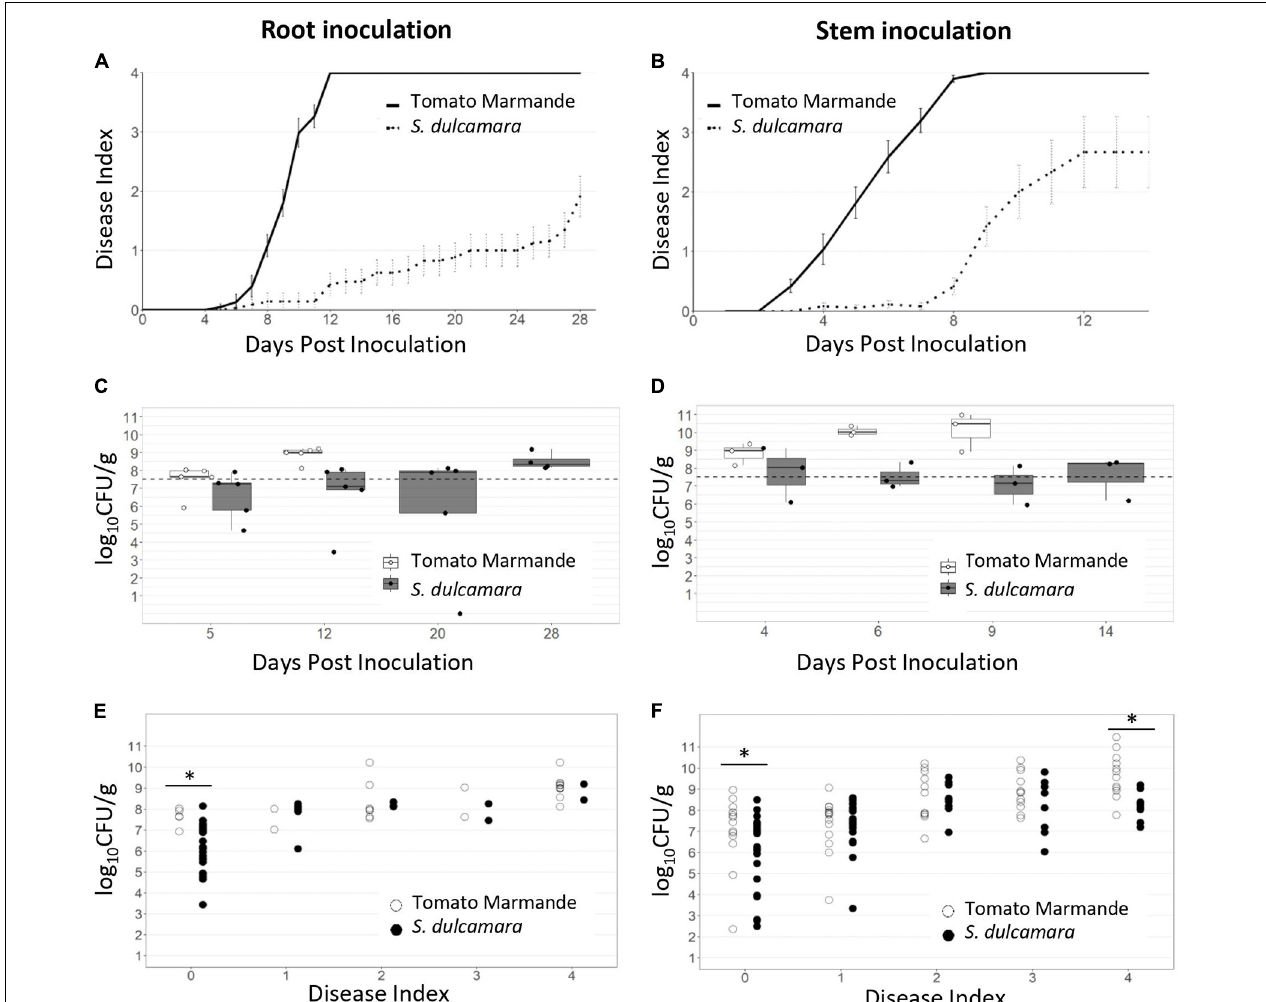
FIGURE 1 | Bacterial wilt evaluation in S. dulcamara and tomato cv. Marmande plants. Plants of the wild reservoir host S. dulcamara and tomato susceptible to bacterial wilt were root inoculated by soil soaking (A,C,E) or stem inoculated (B,D,F) with R. solanacearum UY031 carrying a luminescent reporter. (A,B) Wilting symptoms were recorded over time using a scale from 0 (no wilting) to 4 (completely wilted). n = 30–35 plants per plant species. (C,D) Bacterial concentrations in the stem at different time points from plants in panels (A,B) , respectively. n = 4–8 plants per sampling day. (E,F) Bacterial content in relation to wilting symptoms for each plant individual analysed of the two species. n = 30 plant samples analysed for each species. Bacterial counts are expressed as log CFUs · g − 1 tissue. ∗ indicates statistical differences ( p value < 0.05, T -student significant test). The experiments in panels (A,C) were repeated three times with similar results. The experiment in panels (B,D) was repeated twice with similar